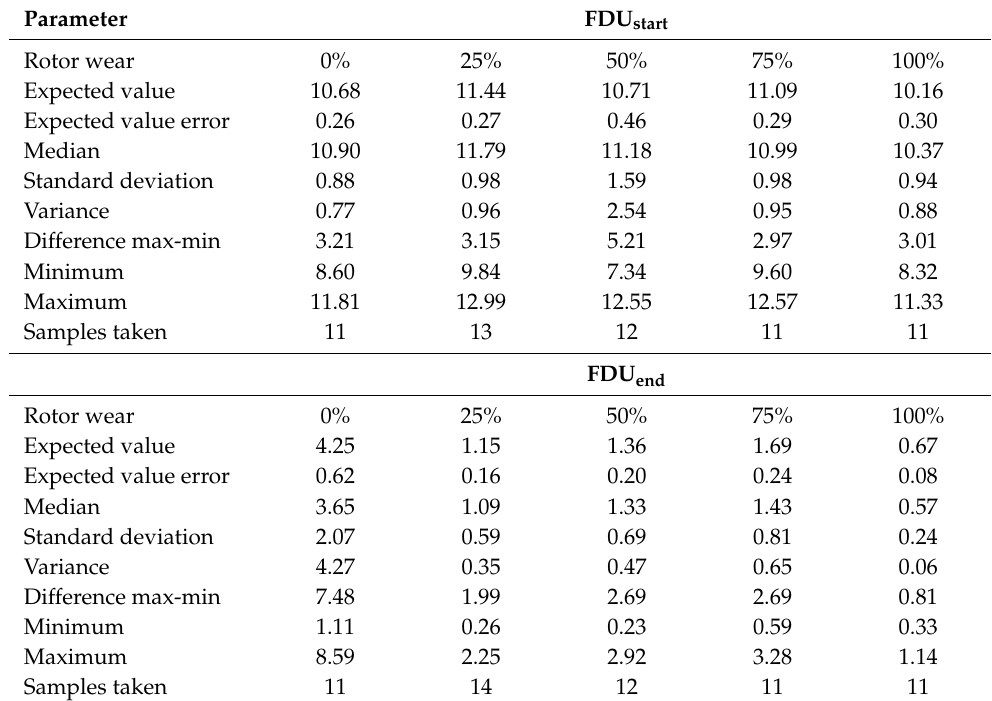
Table 11. Statistical summary of measure values of Dichte Index—type B